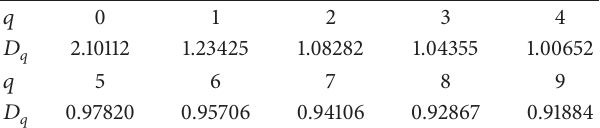
Table 10: The generalized dimension value of outer ring fault